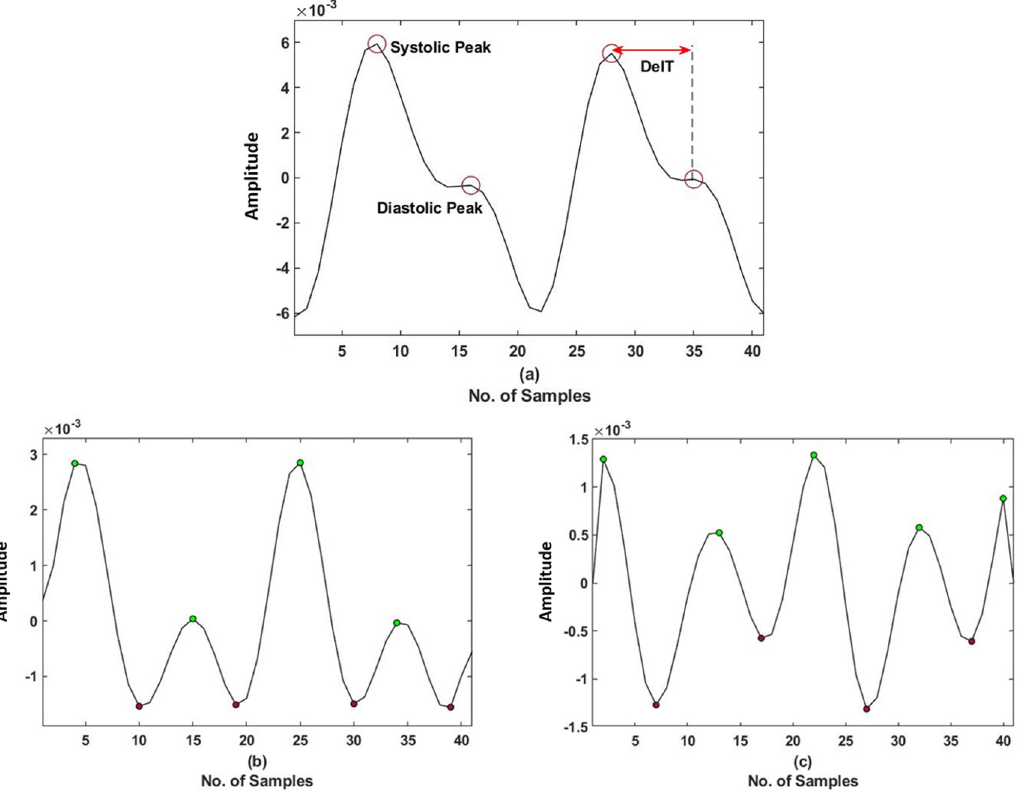
Figure 7. ( a ) A representative PPG single cycle waveform with systolic and diastolic peaks and DelT; ( b ) is the first derivative of that cycle, and ( c ) is the second derivative of the cycle.